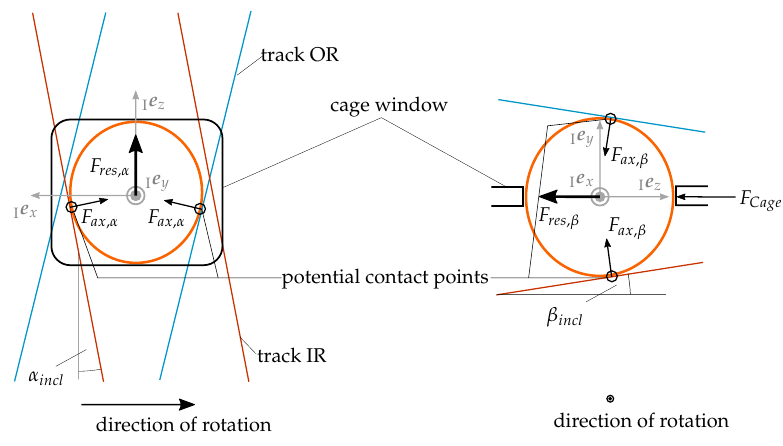
Figure 10. Forces acting on the ball due to the inclination angles α incl and β incl and the